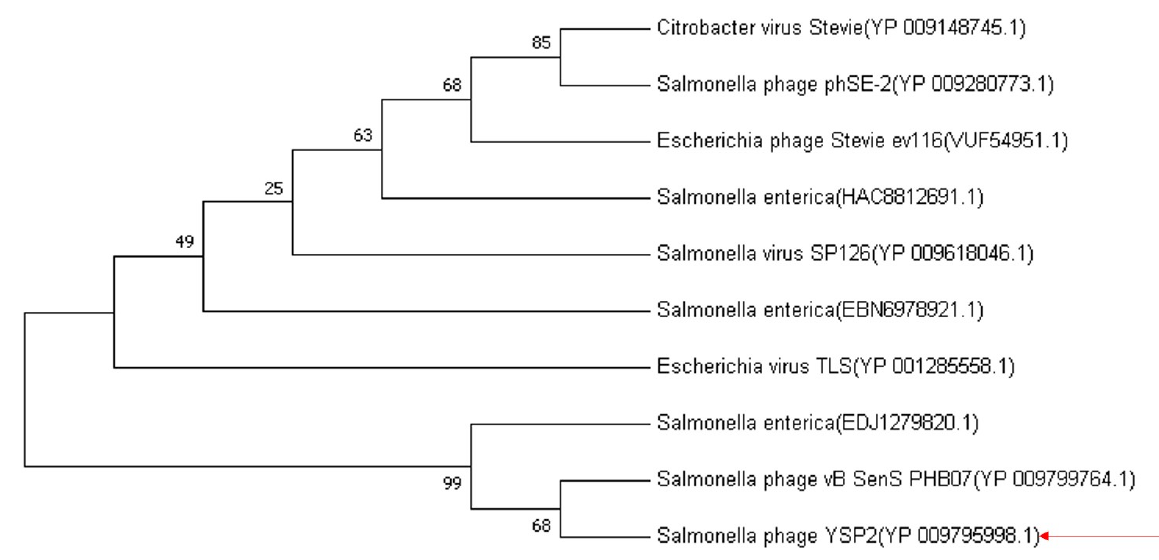
Figure 1. Neighbor-joining phylogenetic tree based on the amino acid fragment of LySP2 and related sequences. Bootstrap values > 50% (based on 1000 replicates) are shown at branch points. GenBank accession numbers are given in parentheses following phage names.